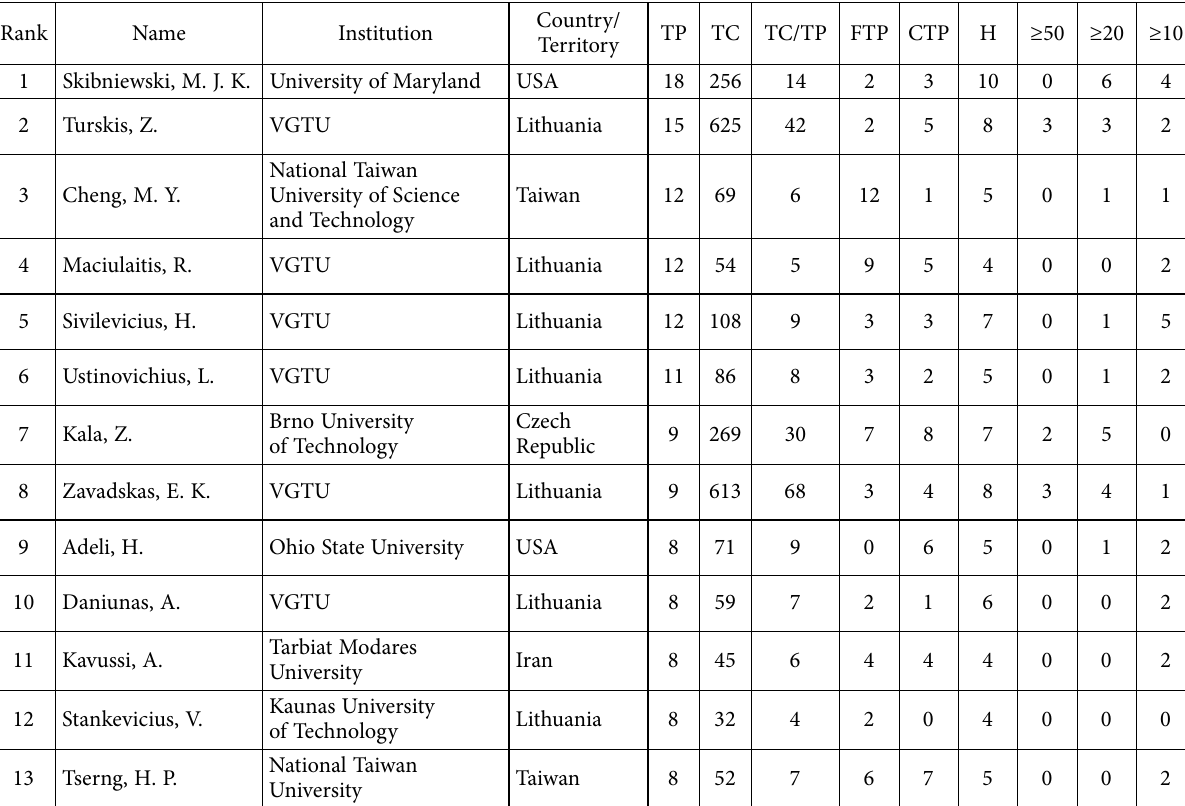
Table 6. The most productive and influential authors of the JCEM